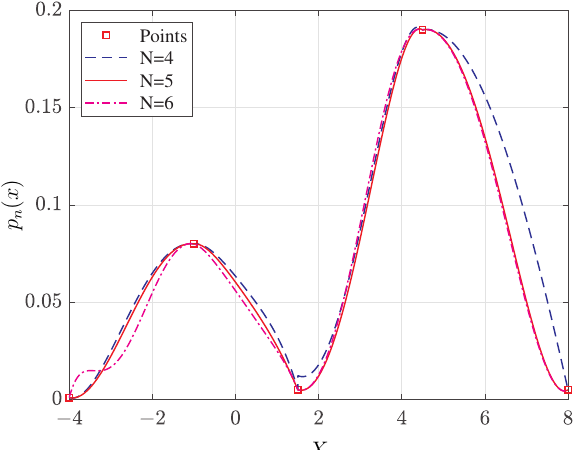
Figure 1. The piecewise polynomial distributions, p n ( x ) , consisting of 4 segments with 5 control points (red squares), when the continuity order C = 2. The segments were computed using 20 equally spaced samples within each